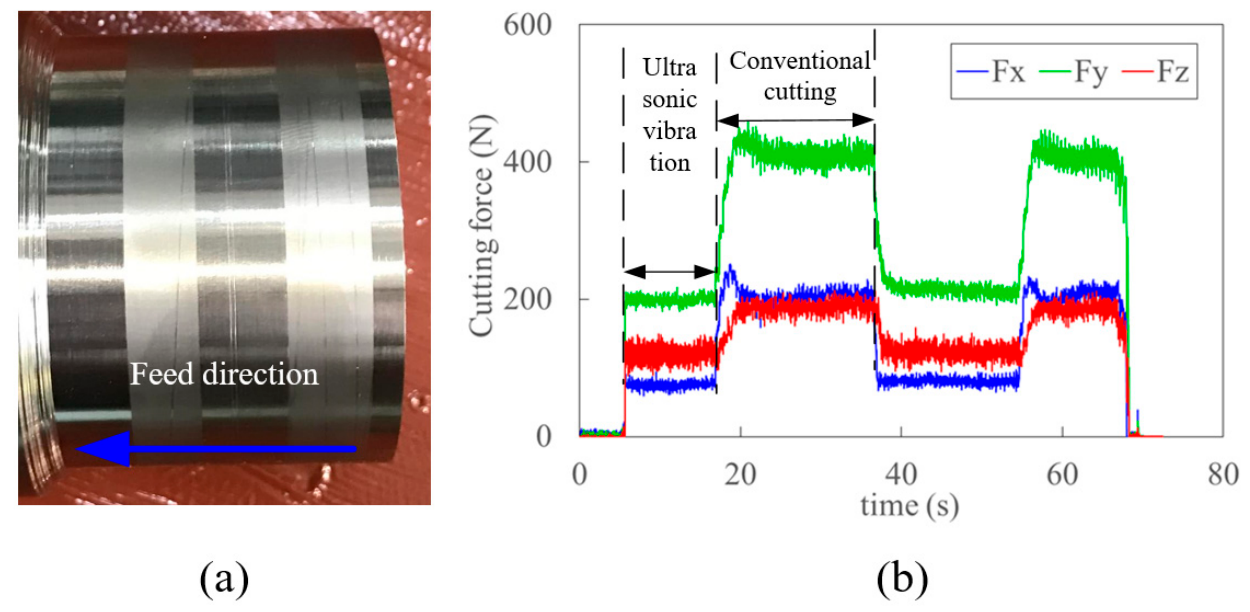
Figure 11. The typical work-piece ( a ) and cutting forces ( b ) in cutting with and without ultrasonic vibration.